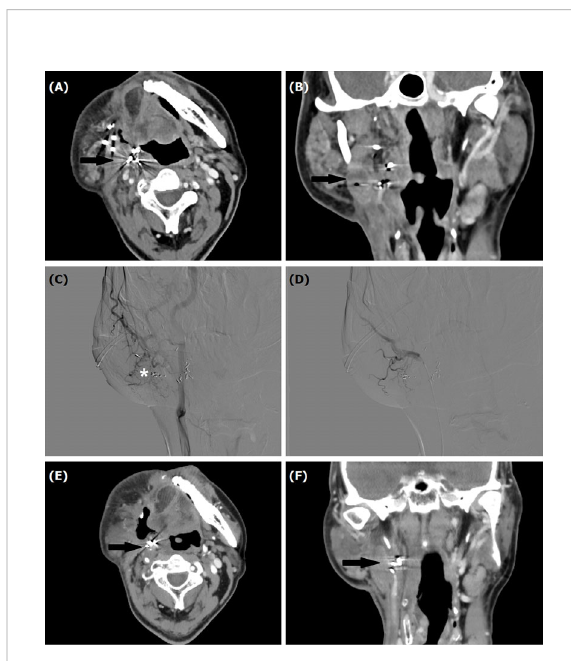
FIGURE 2 A 53-year male treated by TACE for recurrent mucoepidermoid carcinomas in tongue. (A, B) Computed tomography showed a recurrent tumor with Iodine-125 seeds (arrow). (C, D) Tumor staining (*) was shown by angiography, which disappeared after TACE. (E, F) A decreased tumor (arrow) was shown by computed